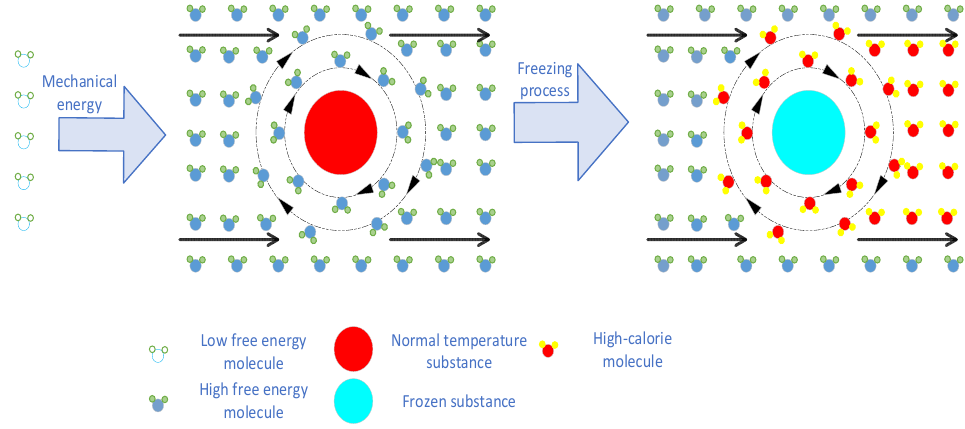
Figure 22. Heat molecular energy exchange diagram.